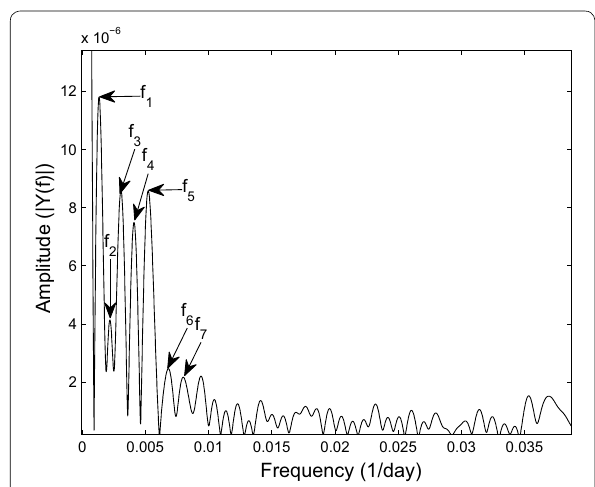
Fig. 2 The frequency spectrum for U ( 1 ) and the first seven main frequency components